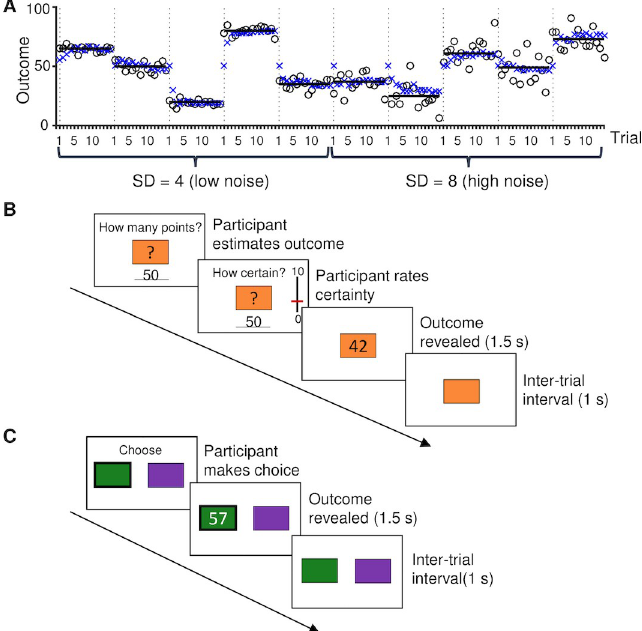
Fig 1. Experimental tasks. A . Example of an adult participant’s estimated and observed outcomes during the estimation task. This participant completed the low-noise (SD = 4) followed by the high-noise (SD = 8) blocks. The dotted vertical lines indicate the first trial of each block. The circles indicate the outcomes on each trial; these were drawn from a normal distribution which mean (horizontal black line) was constant during each 15-trial block. The blue crosses indicate the participant’s estimates. B. One trial of the estimation task (participants completed 10 blocks of 15 trials each). C . One trial of the choice task (participants completed 8 blocks of 20 trials each).